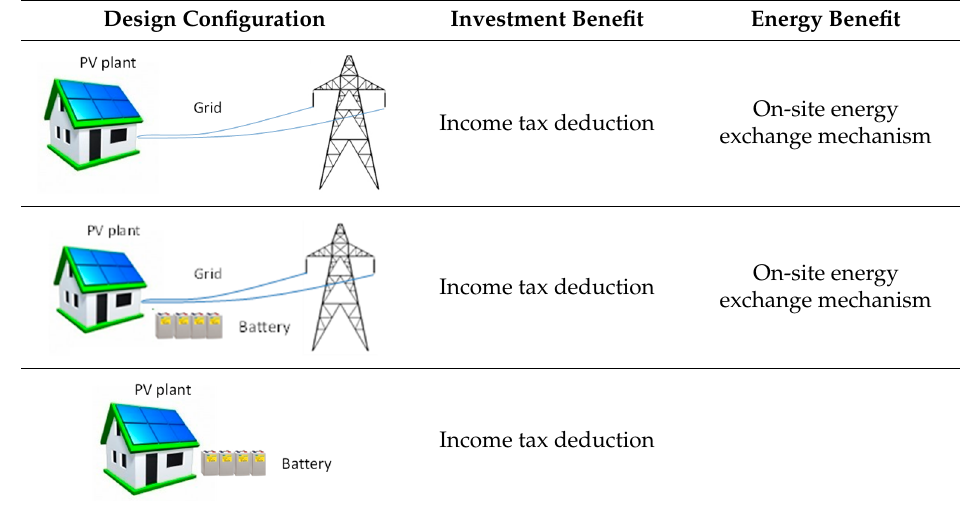
Table 2. Benefits.